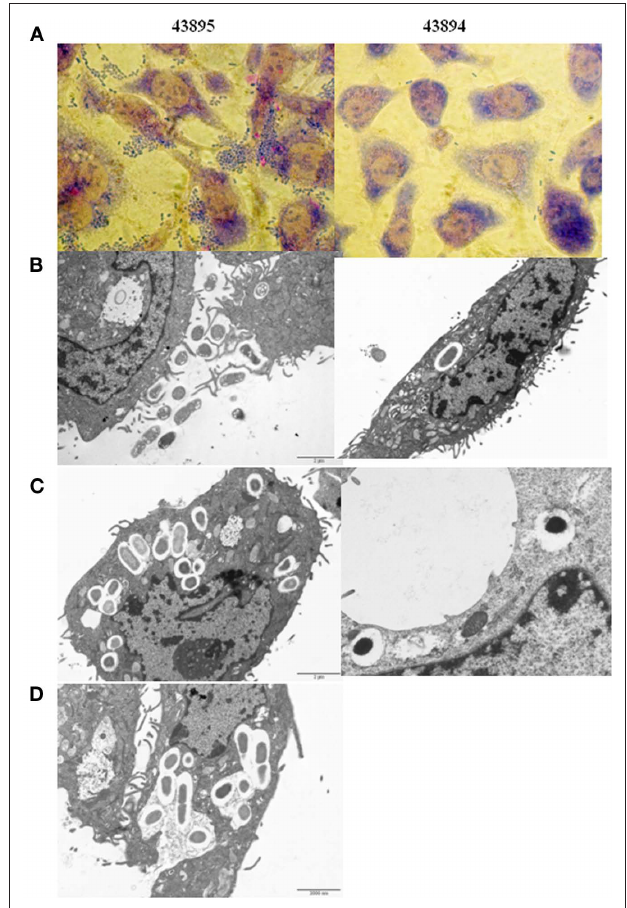
FigUrE 4 | Survival of E. coli O157:H7 in PBrE cells. Bacteria were incubated with monolayers of the PBRE cells at 100 MOI for 4 h. Gentamicin (100 μg/ml) was added for 2, 6, or 24 h incubation. Cells were lysed and plated to LB agar to enumerate surviving bacteria. The bacterial CFU recovered after 2 h Gentamicin treatment was set at 100%. The percentage of intracellular bacteria surviving after 6 and 24 h are shown and each value is the mean of three separate